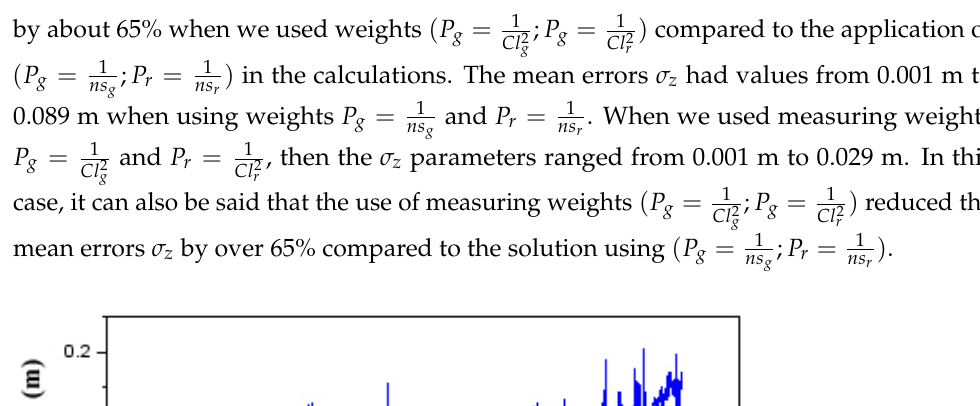
Figure 9. Mean errors